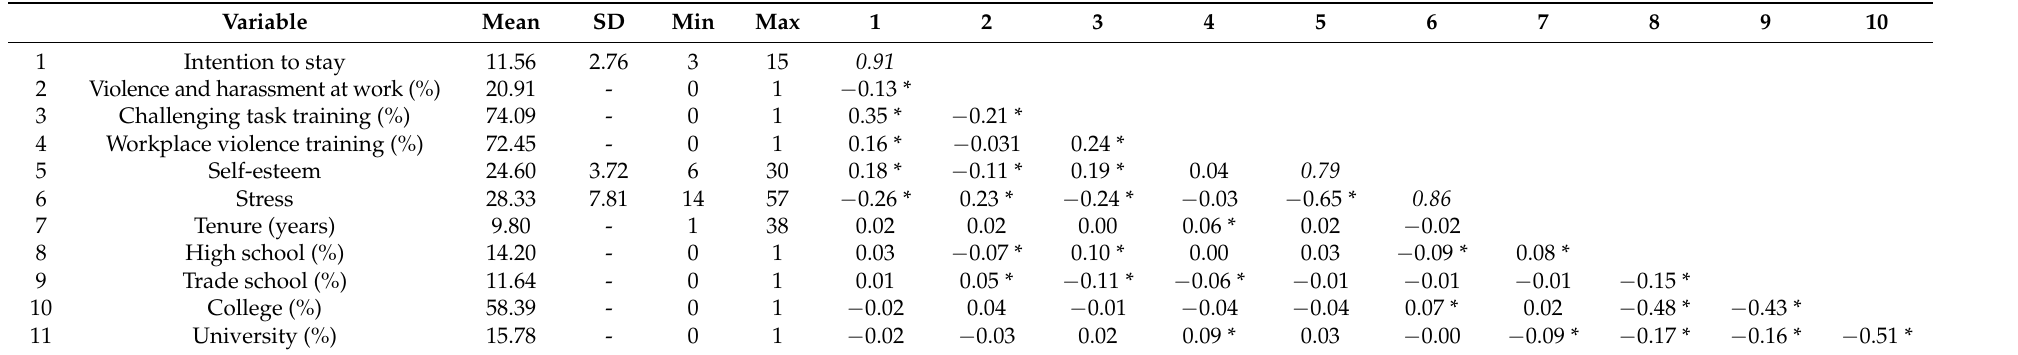
Table 1. Means, standard deviations, correlations, and scale